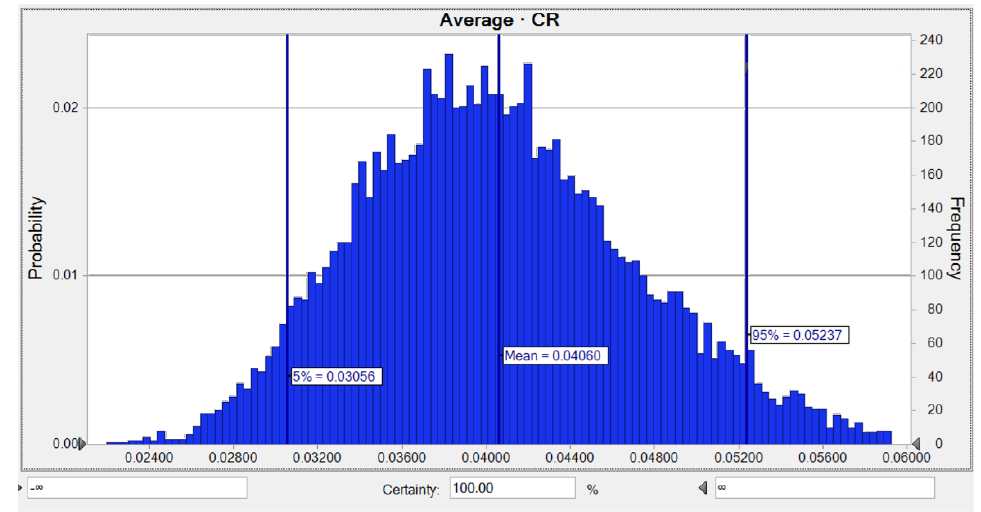
Figure 9. Predicted probability of TCR (children) for As in water.